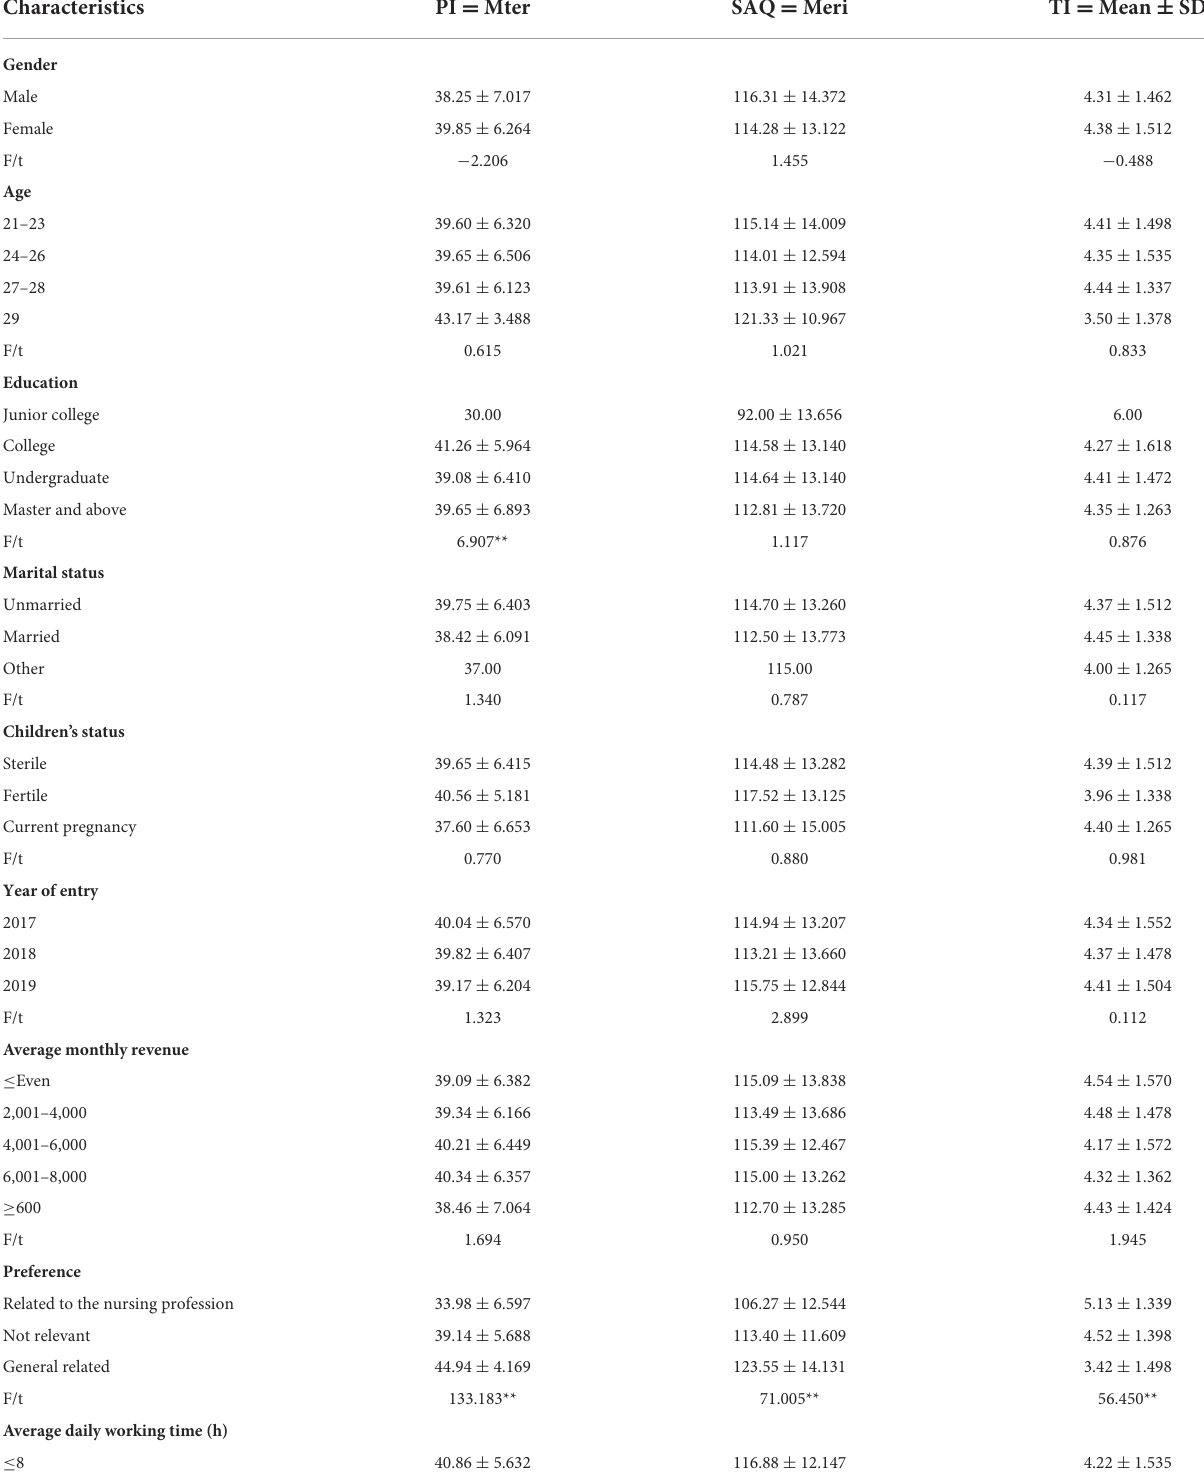
TABLE 3 Difference analysis among